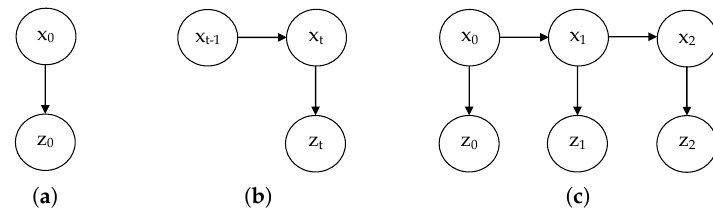
Figure 2. Dynamic Bayesian network corresponding to the obstacle tracking problem. Here, variables x represent hidden states (true distances) while variables z represent observations (sensor